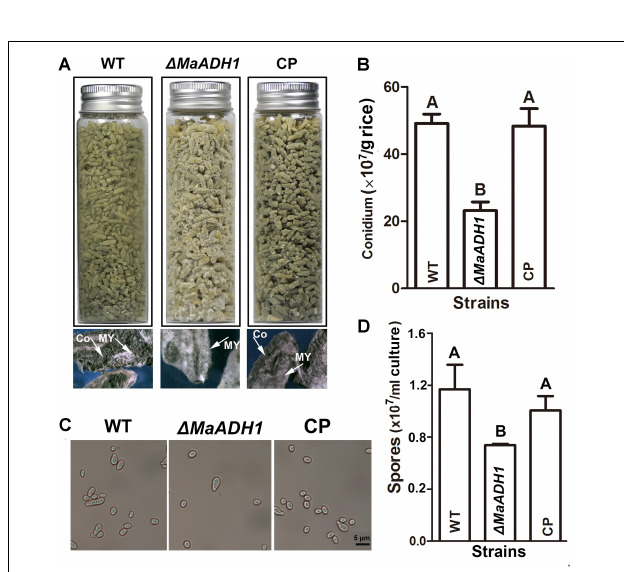
FIGURE 4 | Sporulation under hypoxic conditions. (A) Conidiation after growing on rice under hypoxic condition for 12 days. CO: conidium; MY: mycelia. (B) Quantification of conidiation on rice. (C) Sporulation in liquid medium under hypoxic condition (D) Quantitative sporulation in liquid medium under hypoxic condition. All experiments were repeated at least three times. Error bars, SD. A, B indicate significant difference at p <